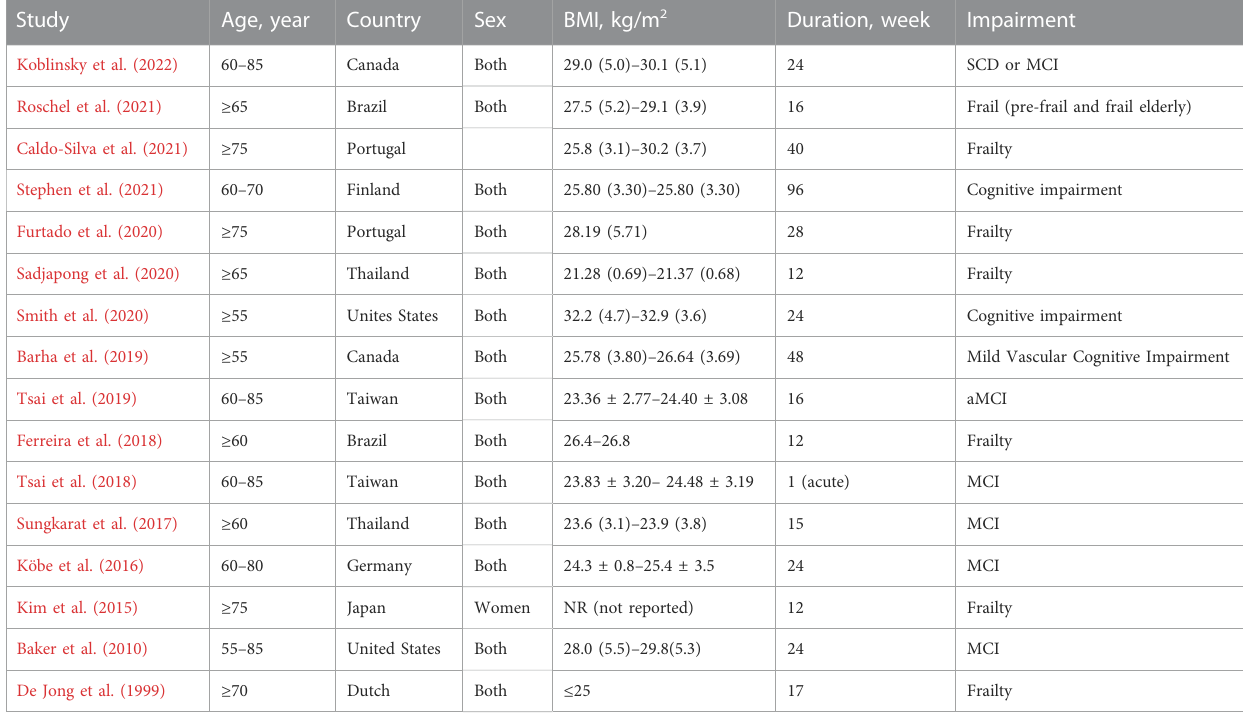
TABLE 2 General characteristic of included